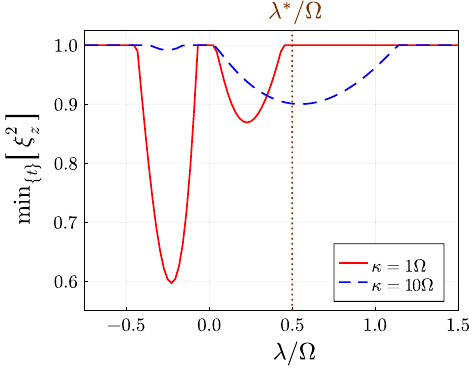
FIG. 7. Spin squeezing obtained by applying the feedback of FIG. 6. Minimum spin squeezing parameter ξ 2 obtained over z Eq. (31) with different feedback strengths, for the (a) good and time as a function of the constant feedback strength for two (b) bad cavity regimes κ = (cid:13) and κ = 10 (cid:13) , respectively. The different values of κ that correspond to the good ( κ = (cid:13) , red green (red) dashed line is obtained when we apply the feed- solid line) and bad ( κ = 10 (cid:13) , blue dashed line) cavity regimes. back with the optimal positive (negative) feedback parameter Better spin squeezing is achieved in the good cavity regime. = 0. The maximum spin squeezing is λ (κ/(cid:13)) The brown dashed line indicates the feedback strength λ ∗ = + ( − ) coherently from t obtained at (cid:13) t = 4 and (cid:13) t ∼ 1.8 for the good and bad cavity 2 κ max { t } (cid:3) J z X (cid:2) / (cid:3) J x ( 0 ) (cid:2) , which is evaluated using the maximum limits, respectively. The blue solid line is the spin squeezing of (cid:3) J z X (cid:2) over time (shown in Fig. 5), and takes the same value (κ/(cid:13)) parameter where we alternate the positive and negative feed- for both κ = (cid:13) and κ = 10 (cid:13) . The values λ − , + of the feed- (κ/(cid:13)) → λ (κ/(cid:13)) → λ (κ/(cid:13)) back following the sequence λ back strength corresponding to the negative and positive minima, + − + , where (κ/(cid:13)) ∗ (κ/(cid:13)) ∗ the switching occurs at times t and t in the good and bad cavity limit, are λ ( 1 ) − = λ ( 10 ) − = − 0.22 (cid:13) , 1 λ ( 1 ) = 0.23 (cid:13) and λ ( 10 ) = 0.55 (cid:13) . + +